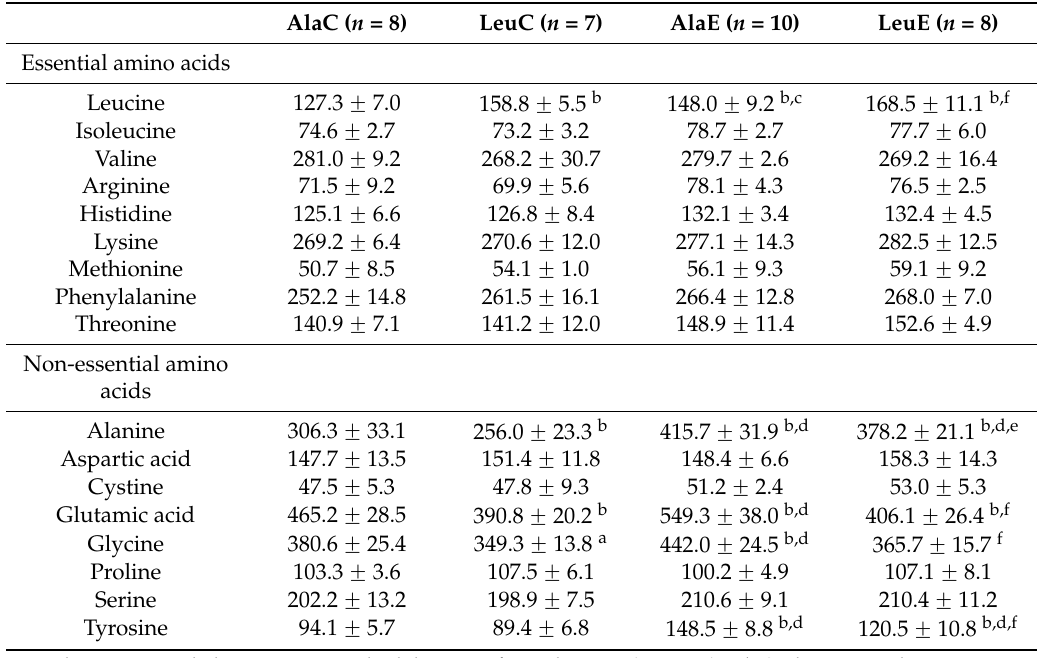
Table 3. Mean plasma amino acids concentrations after 8 weeks of leucine supplementation with/without exercise training ( µ